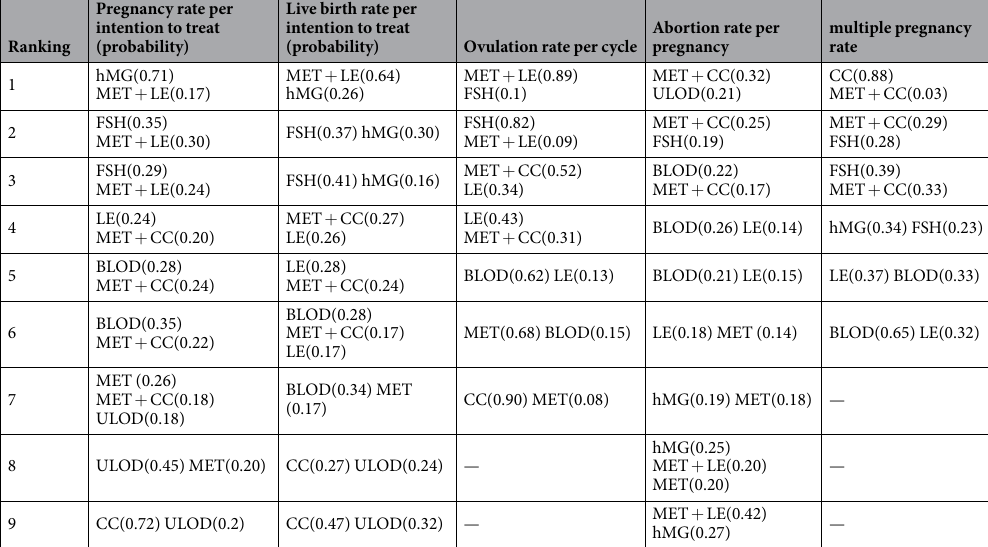
Table 3. The first and second highest probabilities for each ranking over treatment. For pregnancy rate, live birth rate and ovulation rate, rank 1 was the best, and rank N was the worst. For abortion rate and multiple pregnancy rate, rank N was the best, and rank 1 was the worst. The higher the probability was, the more likely it ranked the position. CC: clomiphene citrate, MET: metformin, LE: letrozole, FSH: follicle-stimulating hormone, hMG: human menopausal gonadotropin, MET + CC: metformin combined with clomiphene citrate, MET + LE: metformin combined with letrozole, ULOD: unilateral laparoscopic ovarian drilling and BLOD: bilateral laparoscopic ovarian